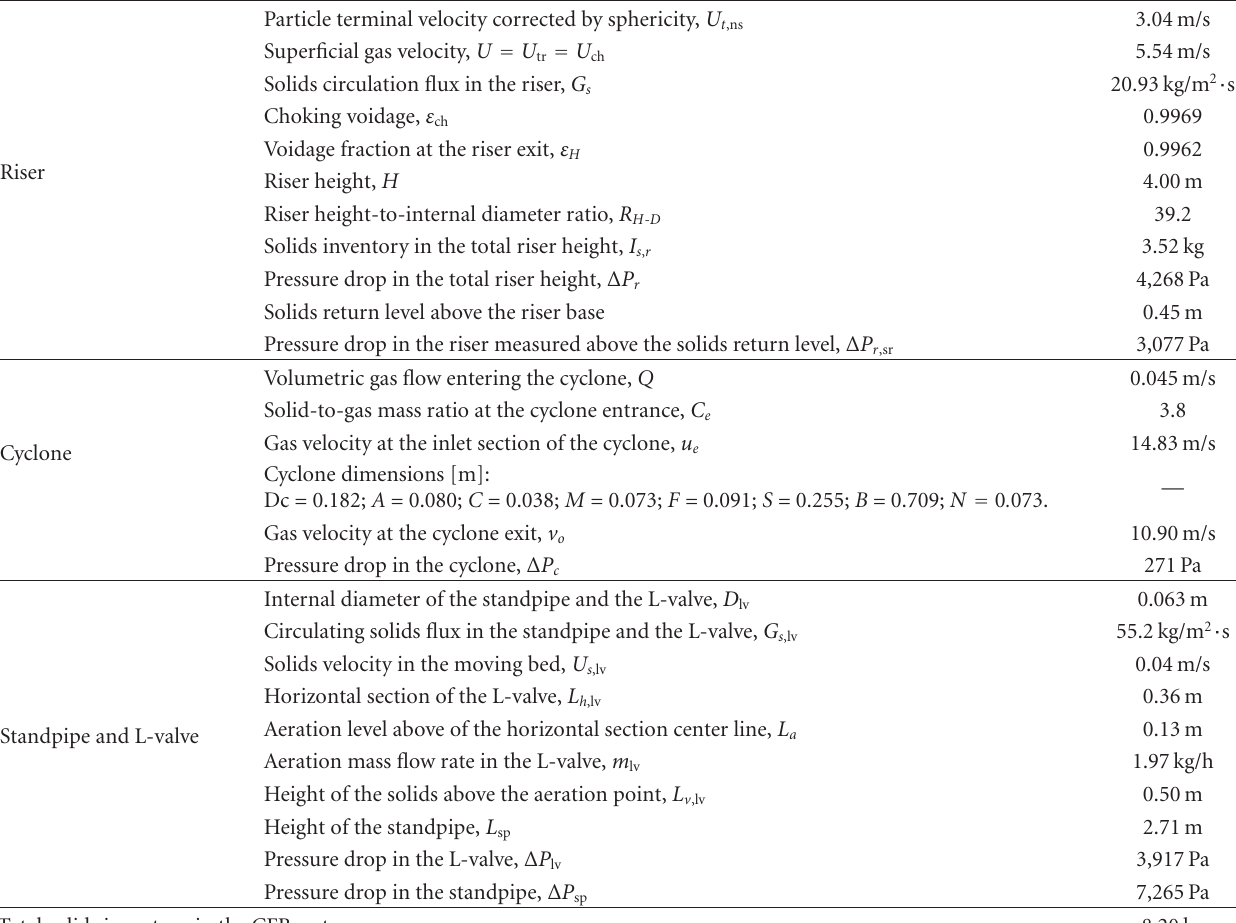
Table 7: Results obtained from the semiempirical